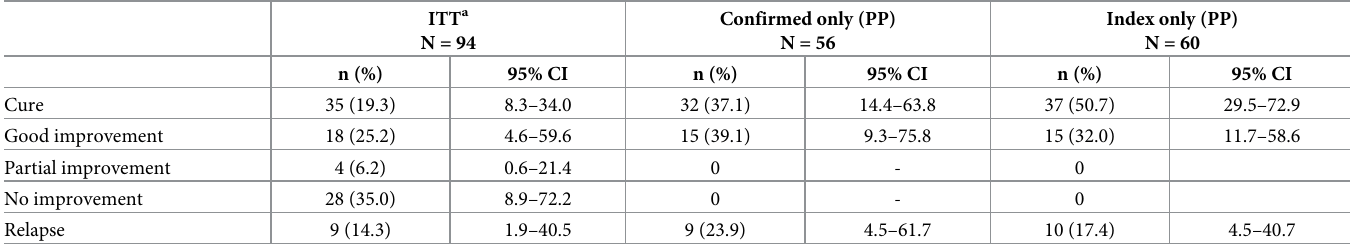
Table 4. Sensitivity analyses for day 90 outcomes for both study sites combined.